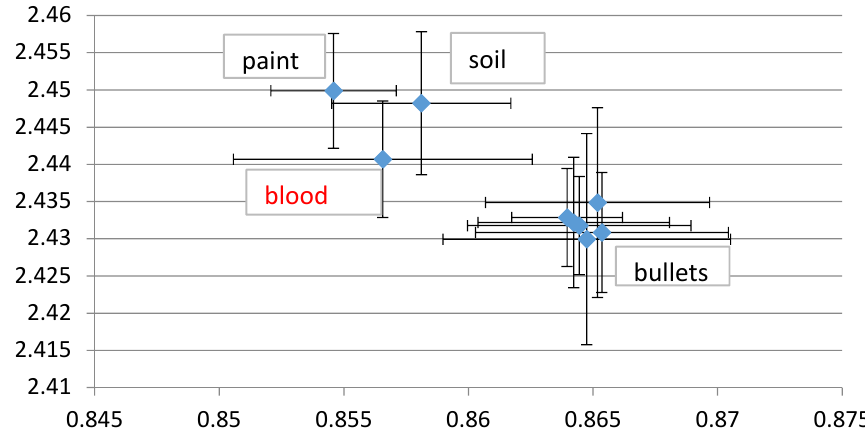
Figure 1. Example 1 of lead isotope ratios (LIRs). The plotted blood LIRs with their confidence intervals ( ± 2 SD) intercept those of paint, soil and bullets.